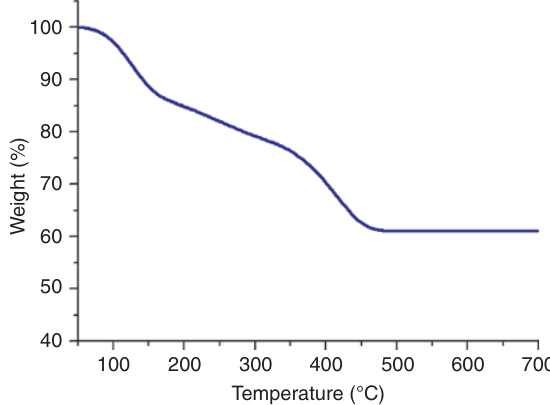
nanoparticles. 2